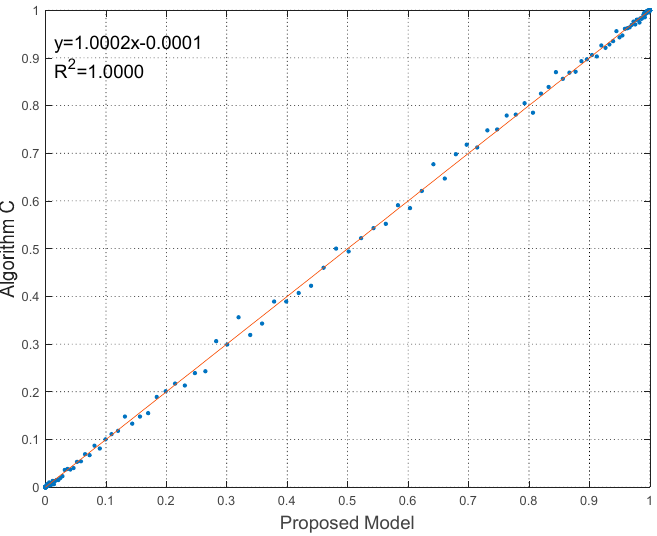
Figure 16. Linear regression of robustness results in Experiment 3.